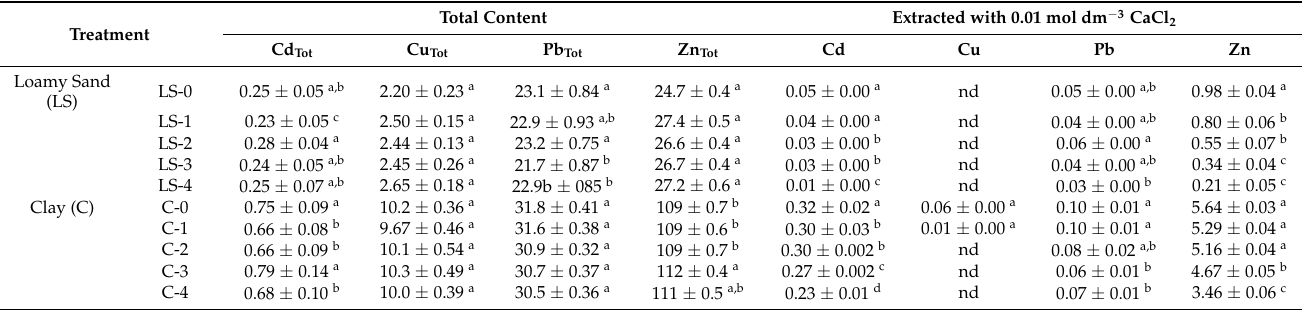
Table 5. The total content of heavy metals (mg kg − 1 ) and heavy metals extracted with 0.01 mol dm − 3 CaCl 2 in the soil after application of CHAR-C ( ± standard